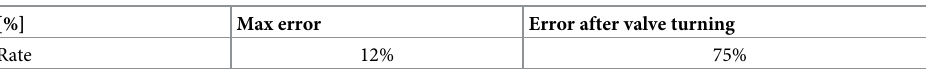
Table 8. Max and final error in each